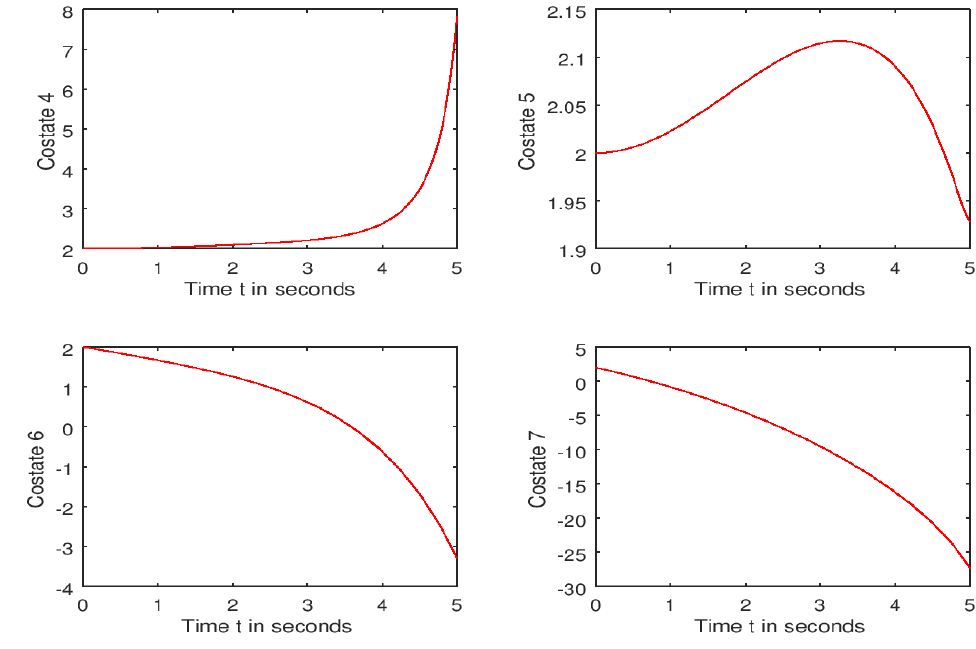
Figure 7. Feasible last four costate functions.